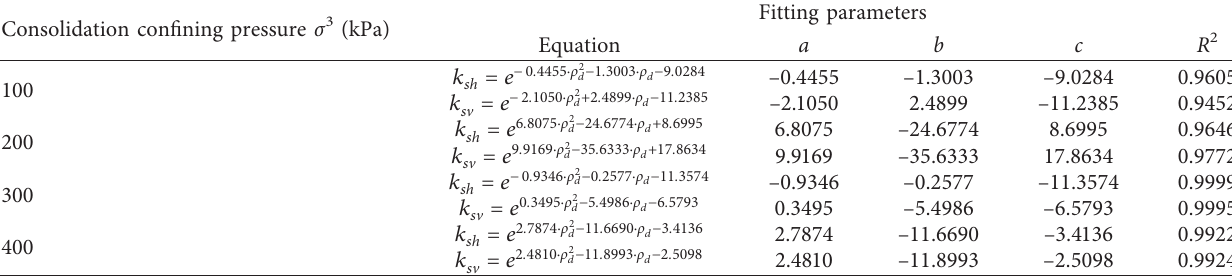
Table 3: Fitting parameters of the saturated permeability coefficient and initial dry density.